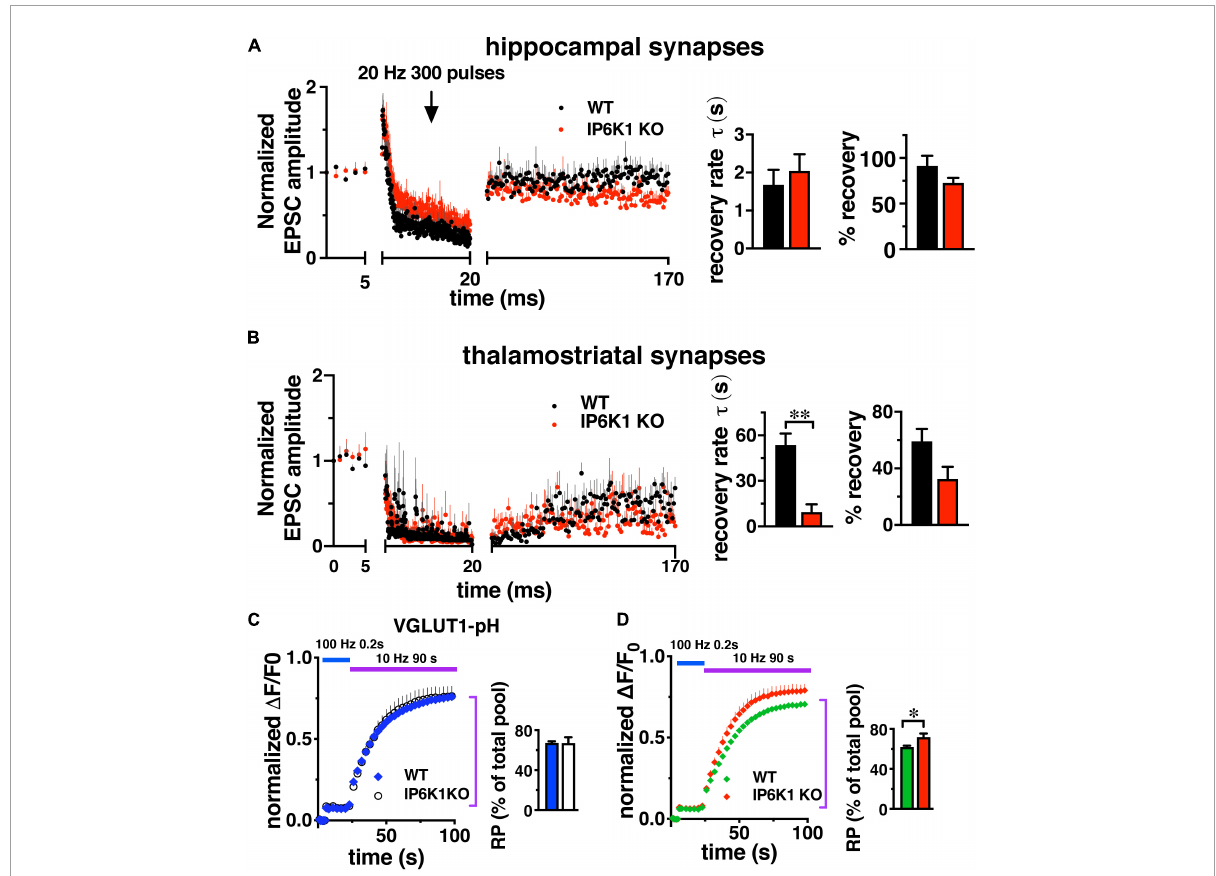
FIGURE6 Response of VGLUT1 expressing hippocampal synapses and VGLUT2 expressing thalamostriatal synapses to prolonged stimulation. (A) CA1: baseline EPSCs evoked at 1 Hz and followed by a 20 Hz 300 pulse train in WT ( n = 6) and IP6K1 KO ( n = 5). Recovery from short-term depression was measured at 1 Hz for 150 s. Currents were normalized to the average amplitudes of baseline EPSCs. Recovery rate time constant was approximated with a single exponential fit. Percentage recovery was calculated based on the recovered EPSC amplitudes. (B) Thalamostriatal: same as in A for WT ( n = 5) and IP6K ( n = 6). ∗∗ p < 0.01, t -test. All data are presented as means ± SEM unless otherwise noted. (C,D) Fluorescence changes representing the amount of VGLUT2-pH, but not VGLUT1-pH, released from the SV recycling pool (RP, purple bar) after release of the RRP (blue bar) is increased in IP6K1 KO mice, compared to control ( ∗ p < 0.05). Data are means ± SEM of (cid:49) F/F 0 normalized to total fluorescence over at least 30 boutons per coverslip from 6 to 9 coverslips and three independent